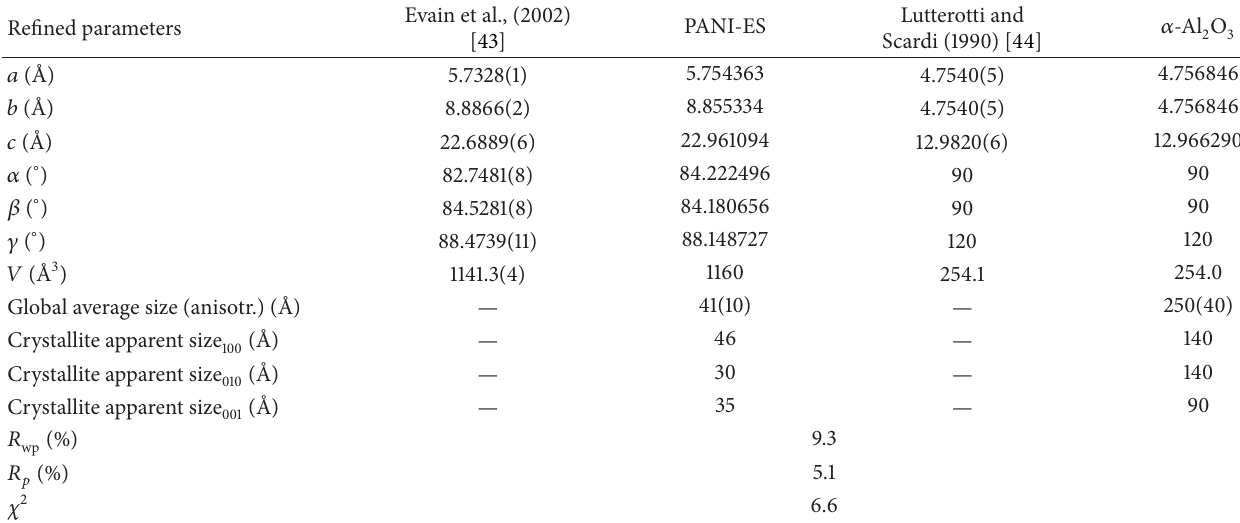
Table 1: Comparison between the values found by Evain et al. (2002) [43] and Lutterotti and Scardi (1990) [44] with those found by PANI-ES O , respectively, through Le Bail method. and 𝛼 -Al 2 3